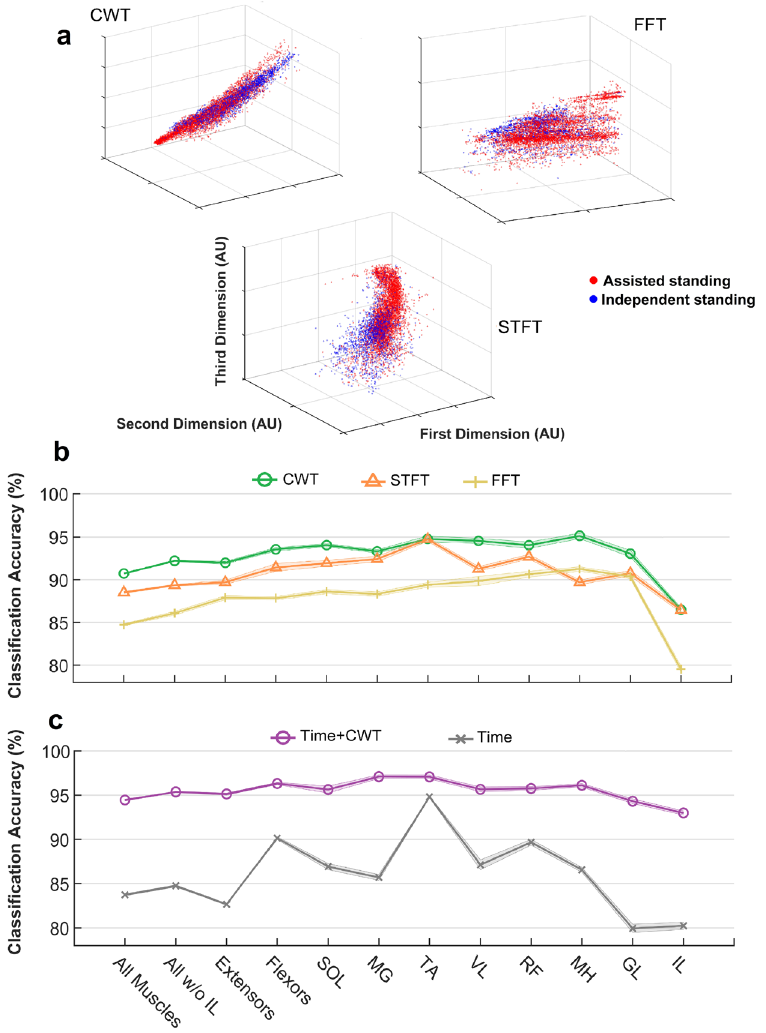
Figure 3. EMG-based classification of assisted vs independent standing. ( a ) First three dimensions of EMG standing data points (blue: independent standing, n = 2032 (127 standing events * 16 muscles); red: assisted standing, n = 4984 (316 standing events * 16 muscles, excluding 72 data points because of technical issues during EMG recordings) after normalization, dimension reduction and logarithmically transforming the spectral feature vectors extracted from Continuous Wavelet Transform (CWT), Short-Time Fourier Transform (STFT) and Fast Fourier Transform (FFT). Independent standing: independent lower limb extension and self-assistance for balance; assisted standing: external assistance for hip and knee extension and self-assistance for balance. K-nearest neighbor classification accuracy of the standing condition (assisted or independent standing) provided by feature vectors extracted from CWT, STFT and FFT (b) , and by time-domain features only or by the integration of time- domain features and CTW-extracted features ( c) , when considering all investigated muscles (left and right soleus (SOL), medial gastrocnemius (MG), vastus lateralis (VL), rectus femoris (RF), gluteus maximus (GL), tibialis anterior (TA), medial hamstring (MH), iliopsoas (IL); all muscles except left and right IL; primary extensor muscles (left and right SOL, MG, VL, RF, GL); primary flexor muscles (left and right TA and MH); and each investigated pair of muscles separately (left and right SOL, MG, TA, VL, RF, MH, GL,